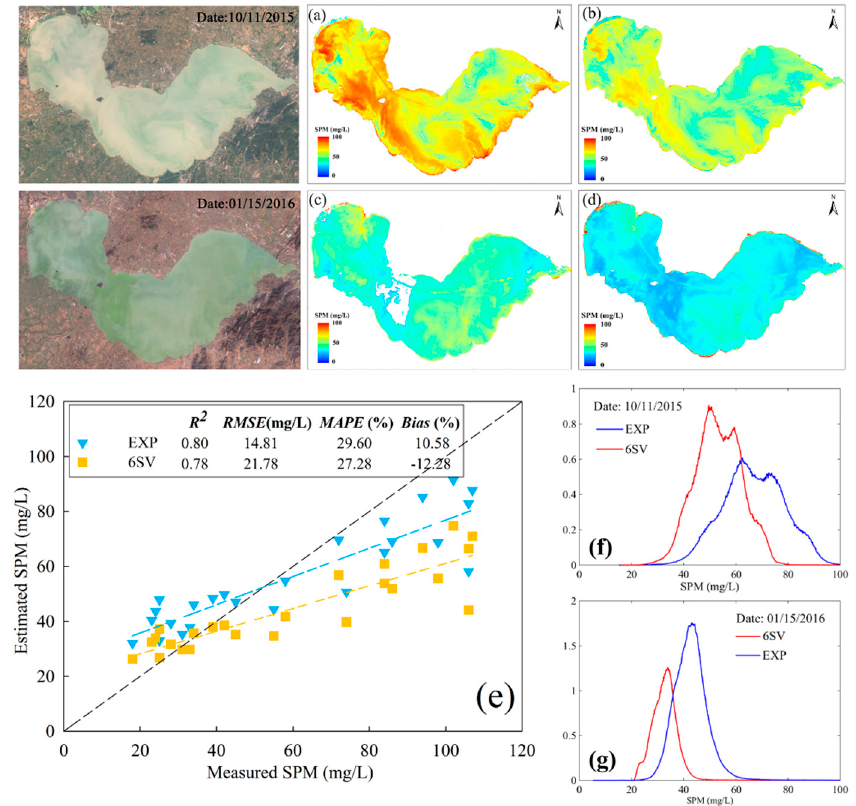
Figure 9. OLI true color image, and distribution of estimated SPM patterns in Lake Chaohu on 15 October 2015, 11 January 2016. OLI-estimated SPM derived by EXP ( a , c ) and 6SV ( b , d ), and frequency of OLI-estimated SPM on 15 October 2015 ( f ) and 11 January 2016 ( g ), blue line was driven by EXP algorithm and red line was driven by 6SV algorithm. The comparison of in situ-measured SPM and OLI-estimated SPM derived by EXP and 6SV ( e ).